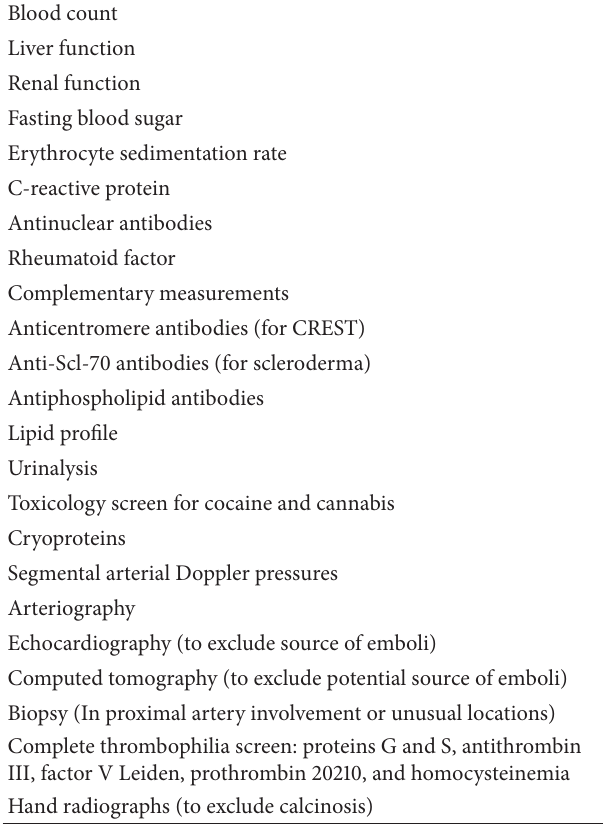
Table 3: Diagnostic investigation for Buerger’s